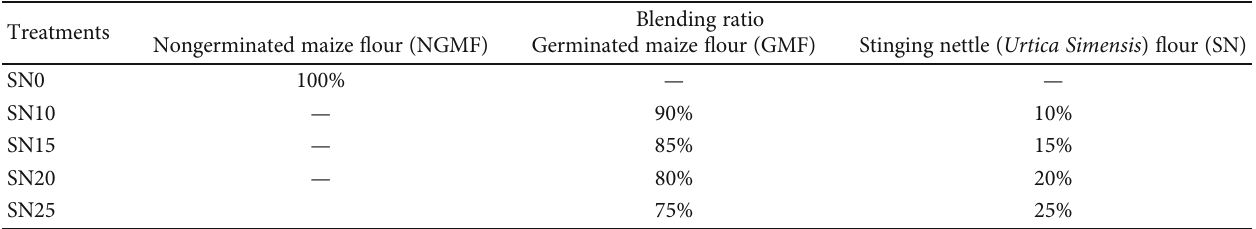
Table 1: Treatment blending ratio of nongerminated maize (NGM) fl our, germinated maize (GM) fl our, and nettle ( Urtica simensis ) fl our.